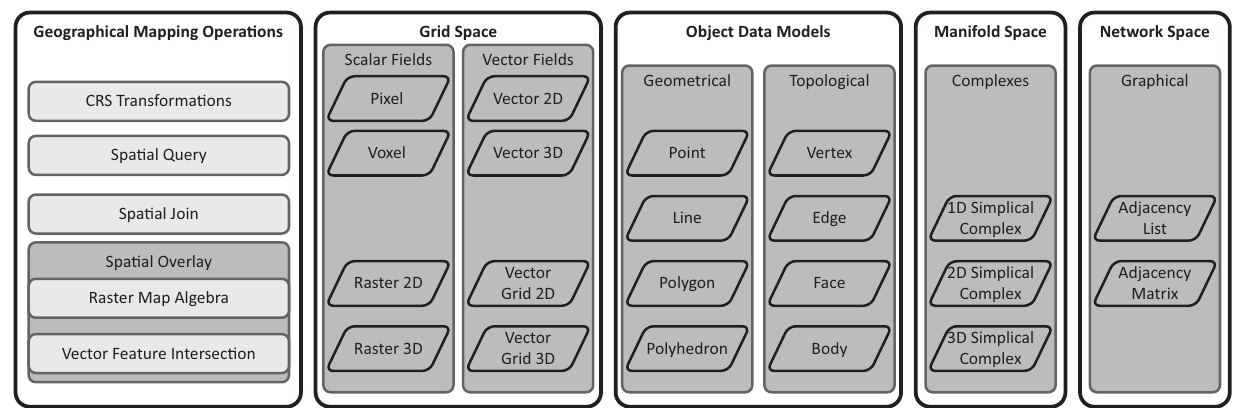
Figure 3. Essential mapping operations and data models required for geo-spatial computing. Interconnection of sensing and actuating devices pro- viding the ability to share information across plat- forms through a unified framework, developing a common operating picture for enabling innovative ap- plications. This is achieved by seamless large scale sensing, data analytics and information representa- tion using cutting edge ubiquitous sensing and cloud